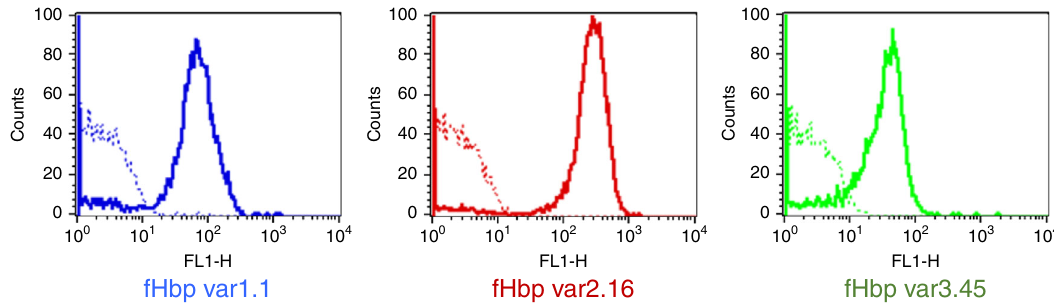
Fig. 8 mAb 1A12 binds meningococci expressing all three fHbp variant groups. Flow cytometry histograms showing the binding of mAb 1A12 to live serogroup B meningococci H44/76, M08-0240104, and M01-0240320 strains (blue, red and green lines, respectively) when incubated with 10 μ g ml − 1 of anti-fHbp mAb. Dotted-line histograms represent negative control, bacteria incubated with PBS and anti-human IgG